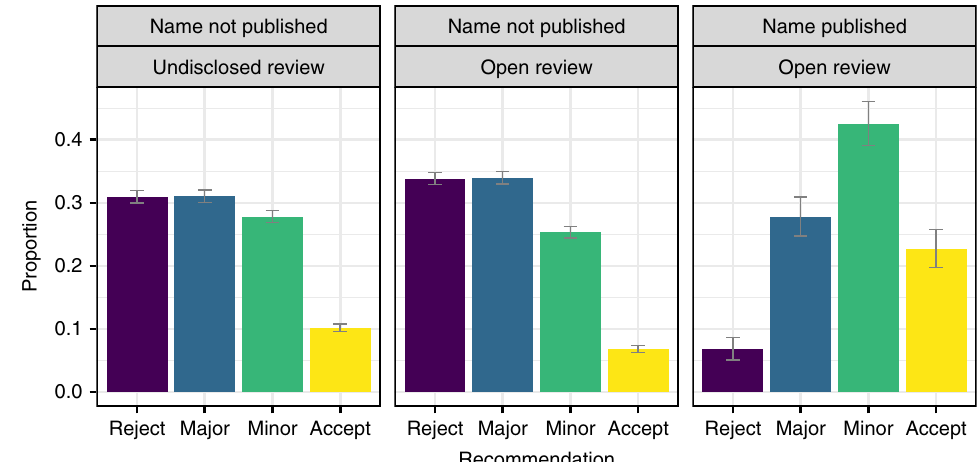
Fig. 4 Proportion of recommendations by review condition and name disclosure. Error bars represent 95% CI obtained via bootstrap (1000